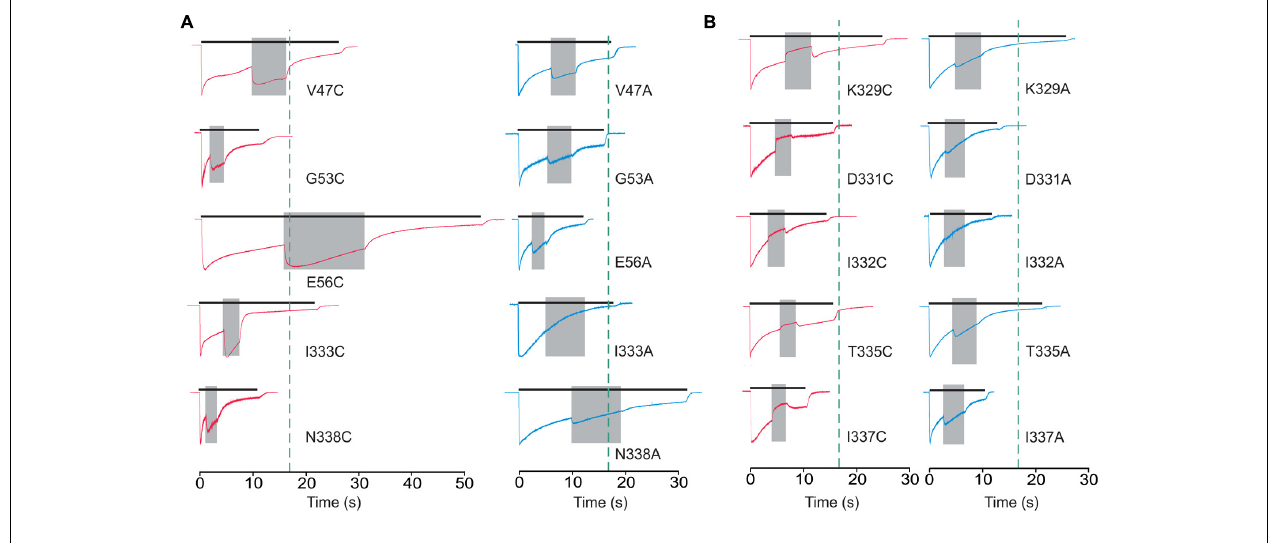
the corresponding alanine mutants (blue traces). (B) A transient inhibition of sustained current by cadmium (red traces). Right panels show the response of the corresponding alanine mutants. Vertical dotted lines illustrate the duration of ATP application in cells expressing the WT receptor. Traces shown are representative and mean ± SEM values for these mutants are shown in Table 1 .